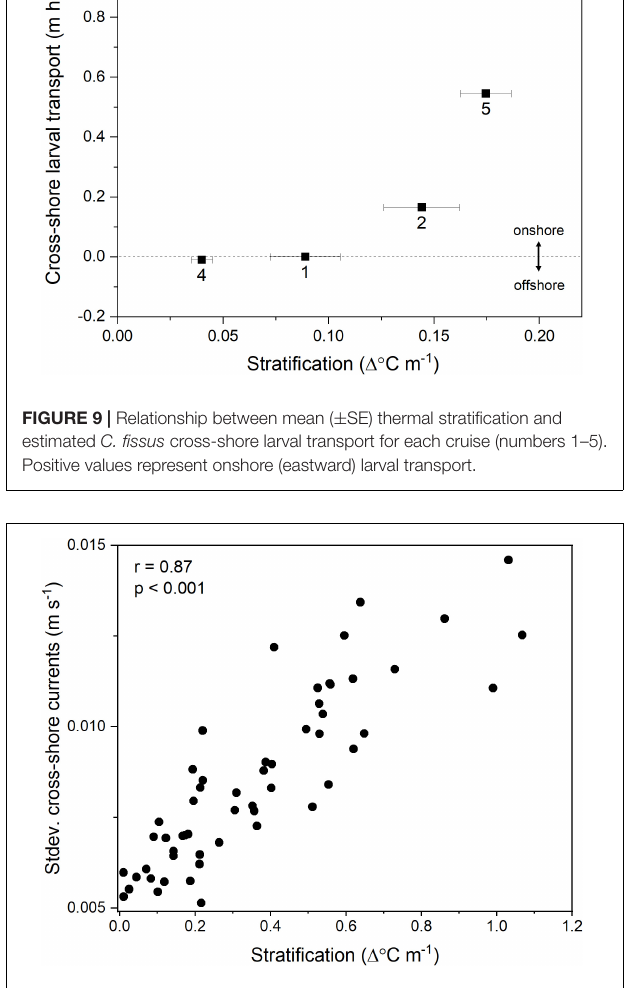
FIGURE 10 | Correlation between thermal stratification and the vertical variability of the high-frequency cross-shore currents (standard deviation across depths of the currents). Points are daily-averages sub-sampled every other day in June and July of 2017 and 2018.